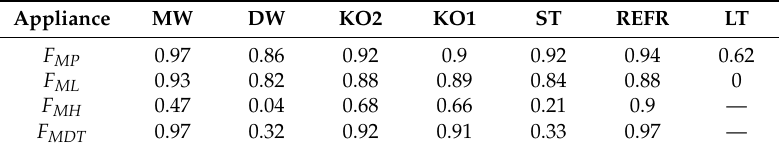
Table 3. Performance of four low-rate NILM algorithms for House 2.